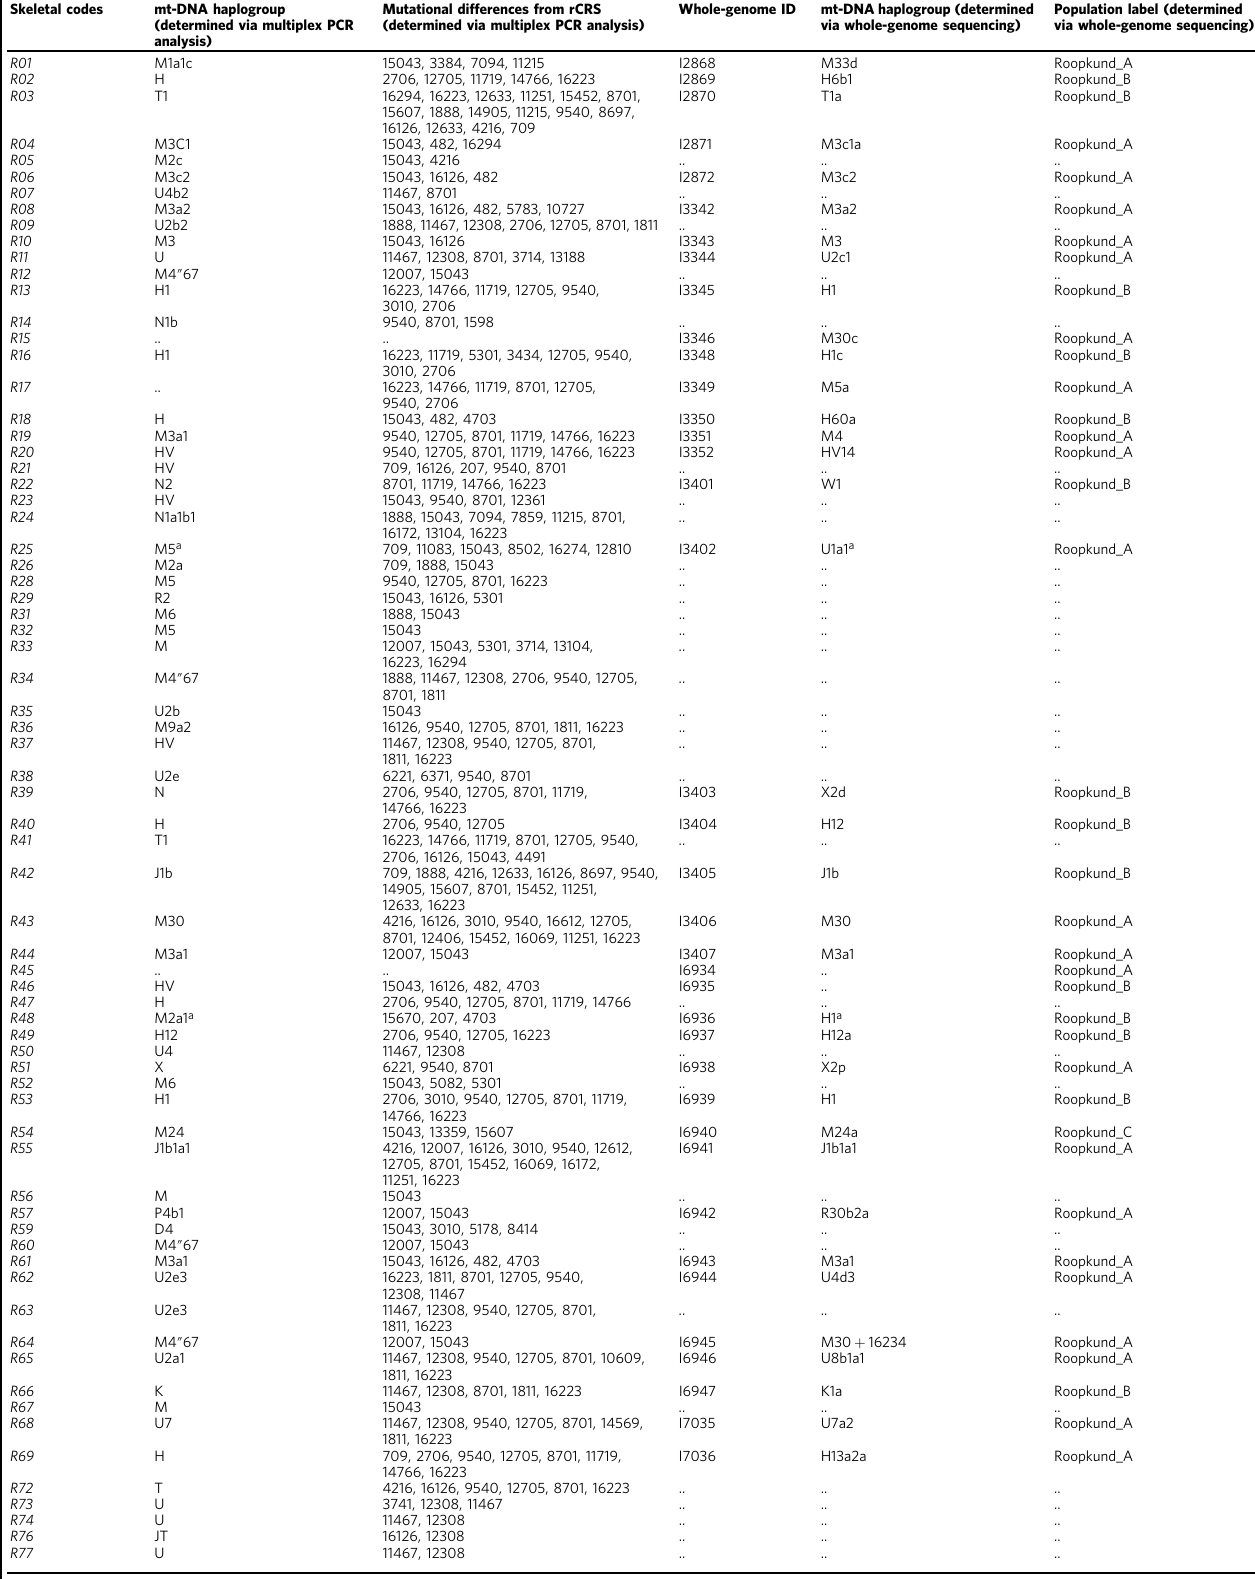
Table 2 Mitochondrial DNA haplogroup determination for 71 individuals Skeletal